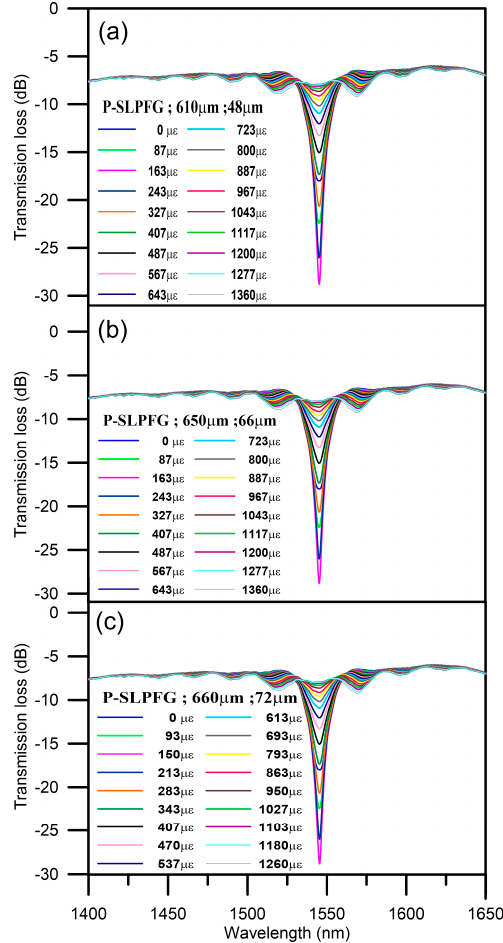
Figure 4. Spectra of the PLPFG under various tensile loadings: ( a ) period 610 μ m, diameter 48 μ m, ( b ) period 650 μ m, diameter 66 μ m, and ( c ) period 660 μ m, diameter 72 μ m.